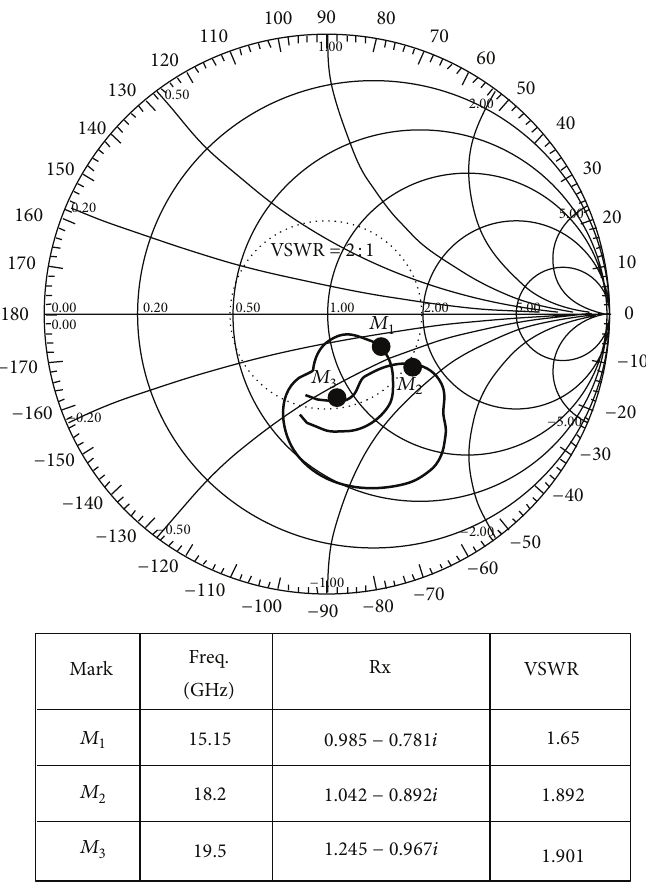
Figure 8: The Smith chart of the proposed